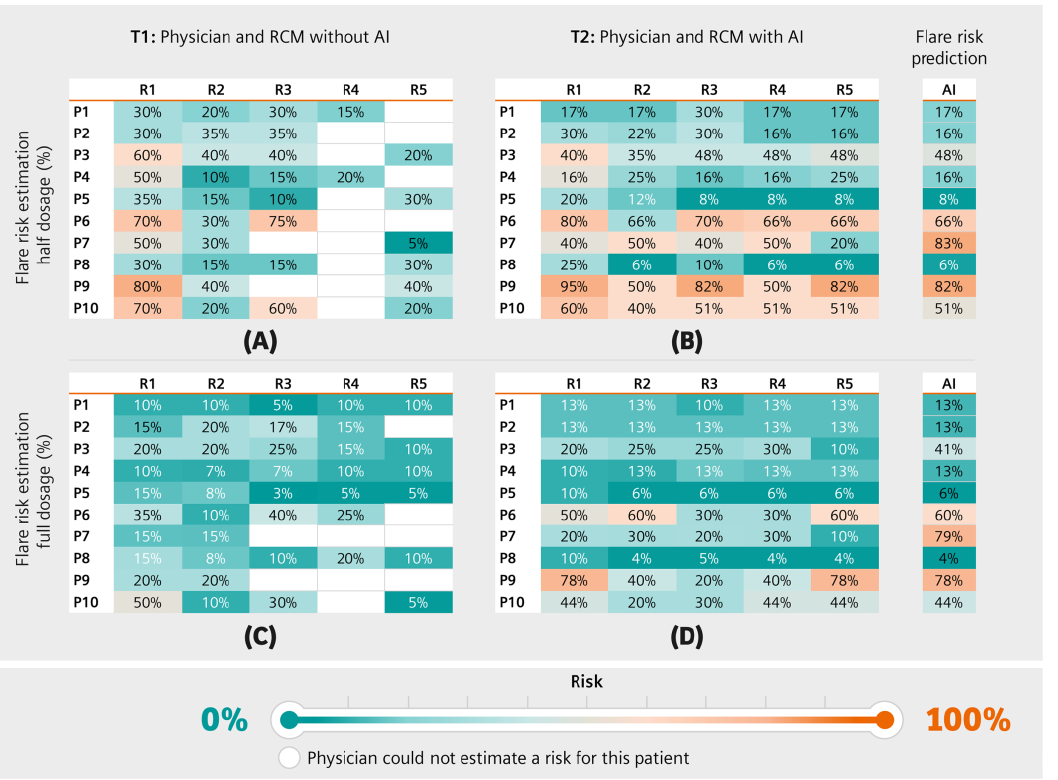
Figure 4. Flare risk prediction. Physicians predicted disease flare risks for half dosage ( A , B ) and full dosage ( C , D ) at T1 (before flare risk prediction tool usage, A , C ) and at T2 (after prediction tool usage, B , D ). AI represents the AI-based flare prediction probability (single column table on the right). Petrol represents low flare risk and orange indicates high flare risk. White denotes that no assessment could be made.